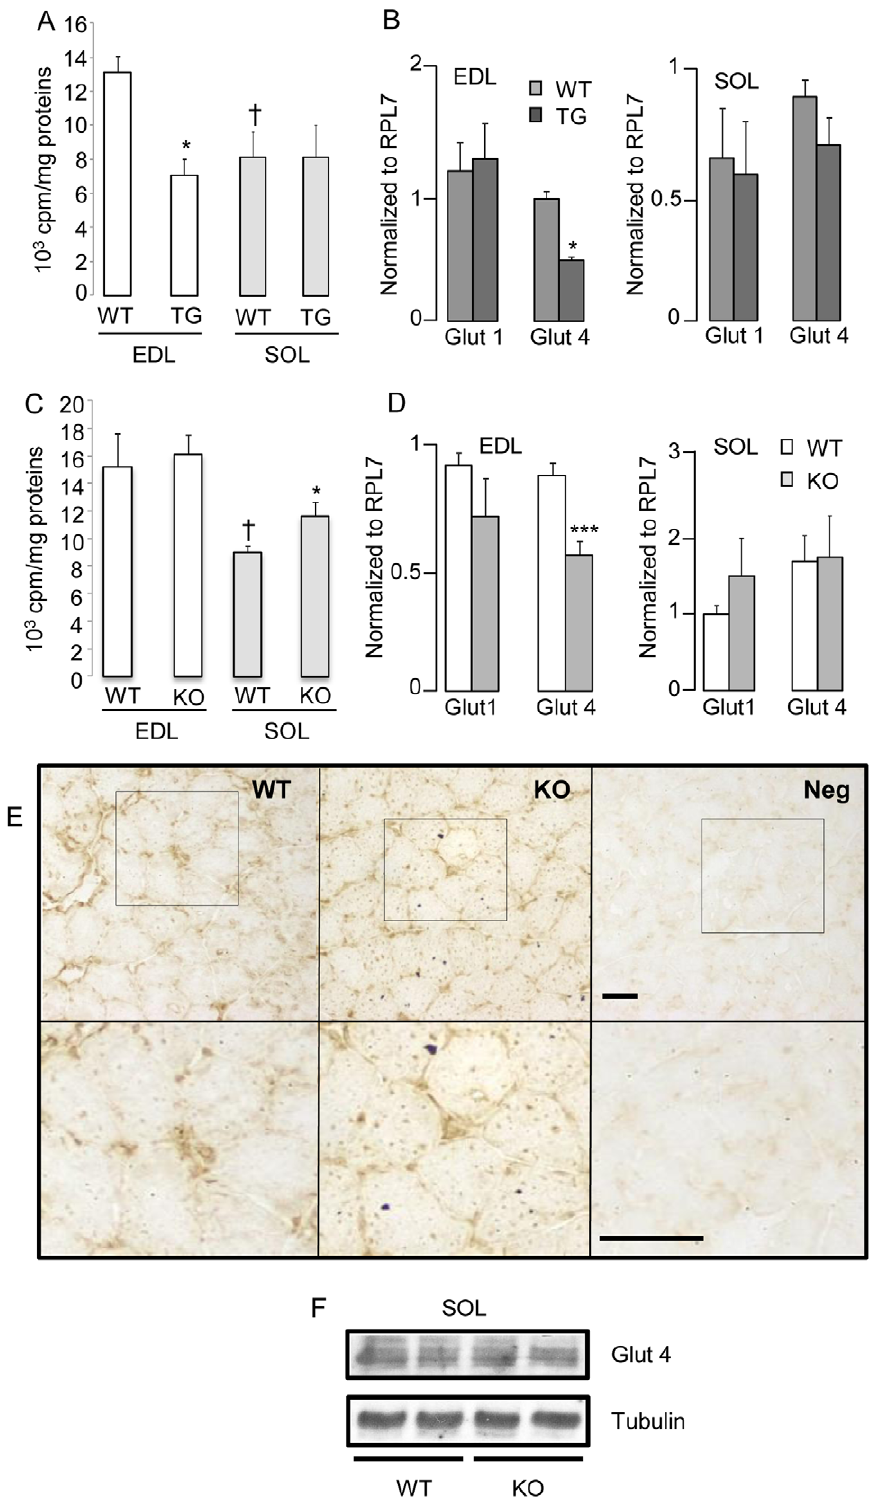
Figure 5. Depletion of RIP140 increases the presence of GLUT4 at the plasma membrane and basal glucose uptake in the soleus. (A) Basal glucose uptake, normalized to proteins, monitored in EDL (n=4) and soleus (SOL) (n=8) isolated from RIP140 transgenic (TG) and WT mice. Data are expressed as mean 6 SEM. *p , 0.05, WT vs KO; { p , 0.05, WT soleus vs WT EDL. (B) Real-time RT-PCR analysis of genes implicated in glucose transport in EDL and soleus (SOL) of RIP140 transgenic (TG) and WT mice (n=4). Data are expressed as mean 6 SEM, *p , 0.05, WT vs TG. (C) Basal glucose uptake, normalized to proteins, monitored in EDL and soleus (SOL) isolated from RIP140-null (KO) versus WT mice (n=4–8). Data are expressed as mean 6 SEM, *p , 0.05, WT vs KO; { p , 0.05, WT EDL vs WT soleus. (D) Real-time RT-PCR analysis of genes implicated in glucose transport